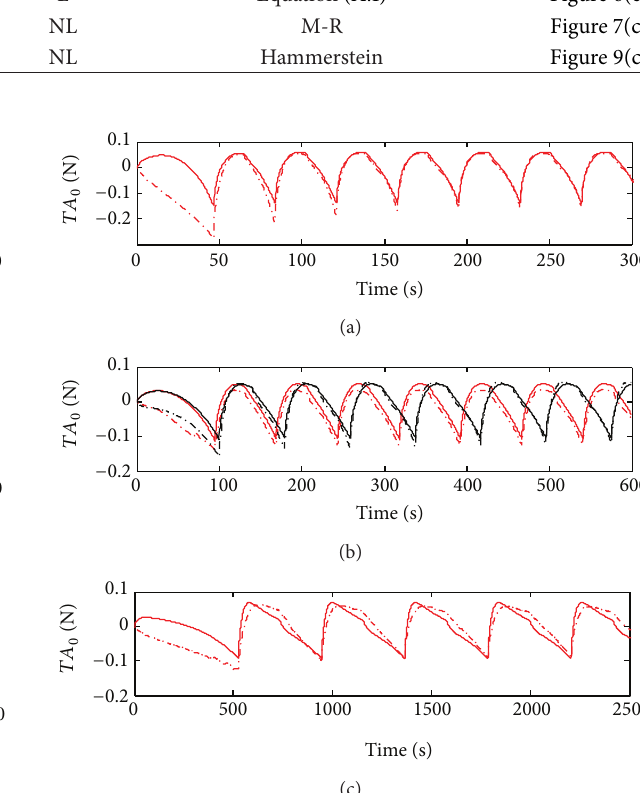
Figure 6: Linear system identification. (a) Identification data using (A.1) and srivc algorithm. Measured and estimated data are shown in dashed-dotted and continuous red line, respectively. Validation data of sample 2 (red) and sample 3 (black) are shown in (b), with the same lines code. (c) shows the validation data of sample 4.